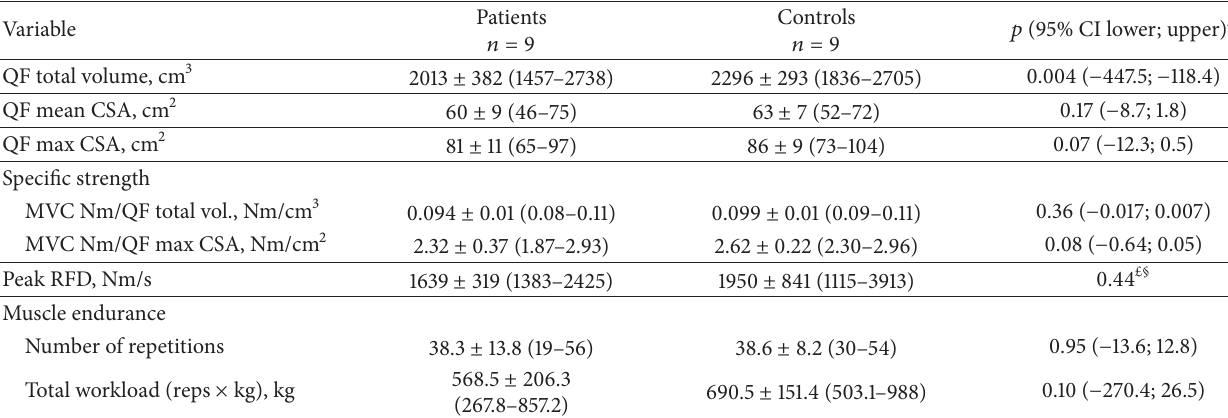
Table 2: Quadriceps femoris: parameters of volume, CSA, and muscle function ∗ .